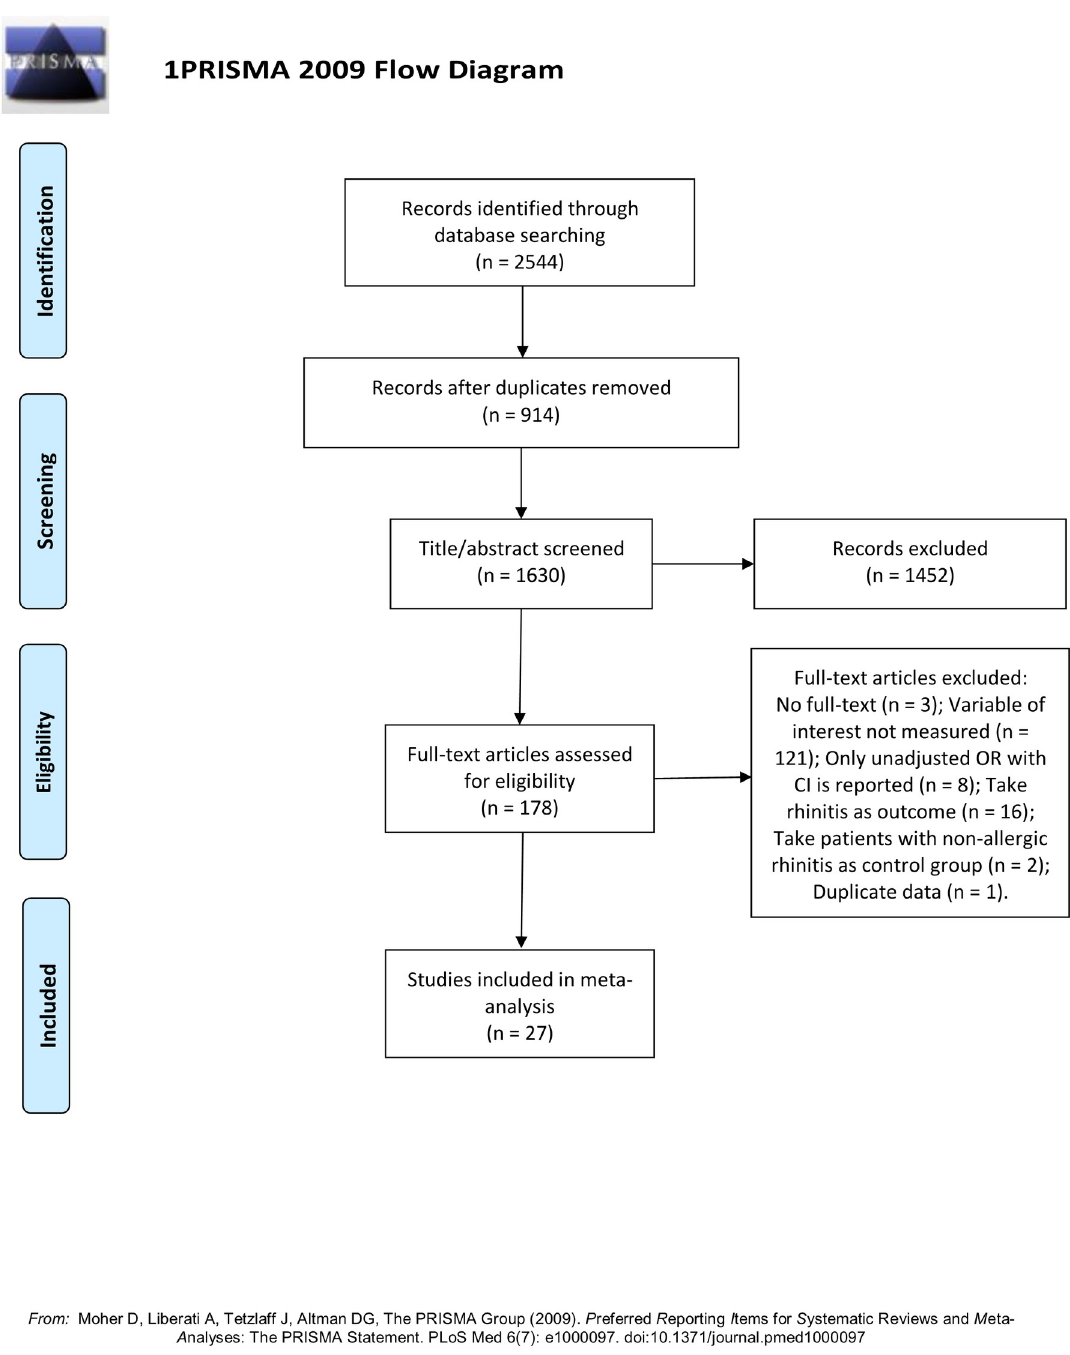
Fig 1. Flow diagram of the literature search and selection